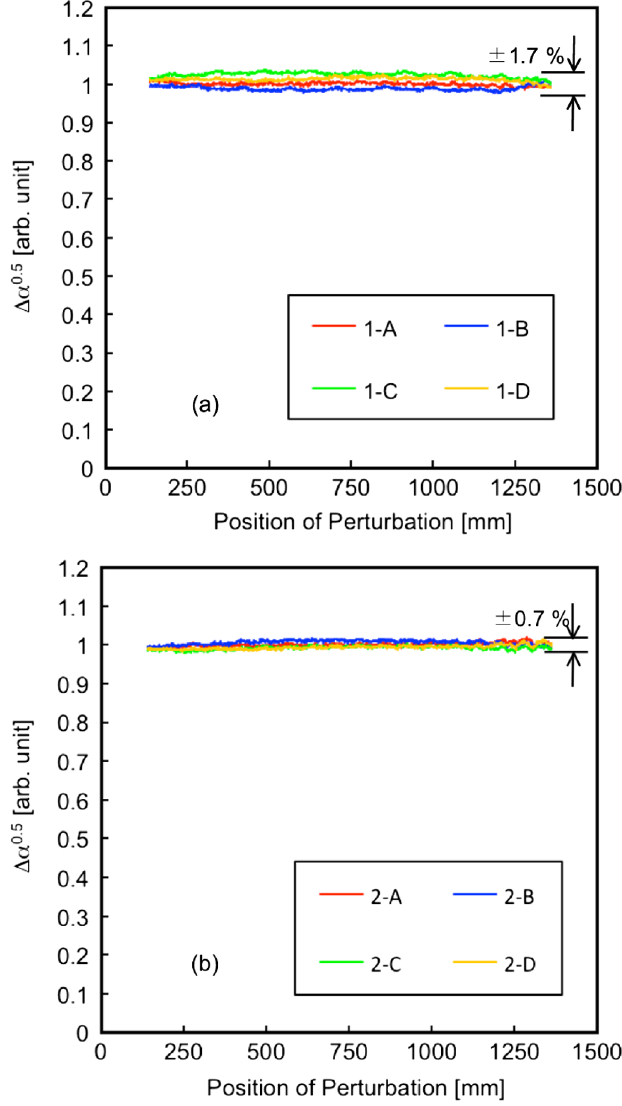
FIG. 23. Distribution plots of the electric field strength interrod along the cavity: (a) channel 1 and (b) channel